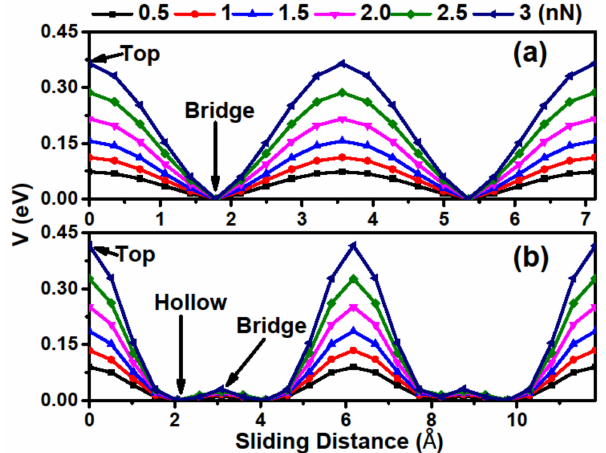
Figure 4. Potential barrier V curves along the sliding direction under different loads. ( a , b ) V curves of paths I and II,